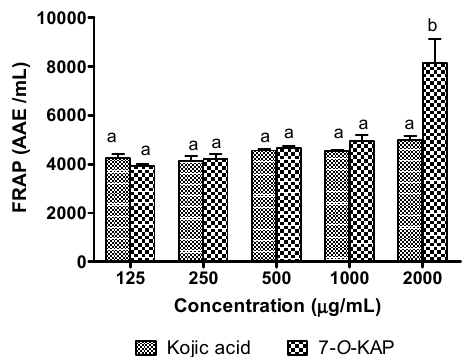
Figure 10. Ferric ion antioxidant power (FRAP) of kojic acid and 7- O -kojic acid monopalmitate (7- O - KAP). Data are presented as means ± S.E.M, and expressed as number of gram equivalents of ascorbic acid per mL (AAE/mL), n = 3. The letters a and b indicate significant difference at p < 0.05 with 37.06%, 23.10%, and 11.56%, respectively. Bonferroni’s Multiple Comparison Test.